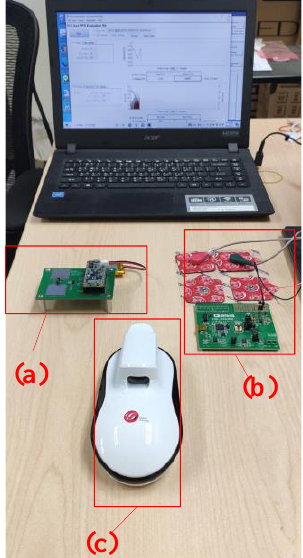
Figure 2. Experimental environment and equipment layout: ( a ) the PPG waveform measuring instrument; ( b ) the bioelectrical impedance value measuring instrument; ( c ) a commercially available noninvasive glucose meter.